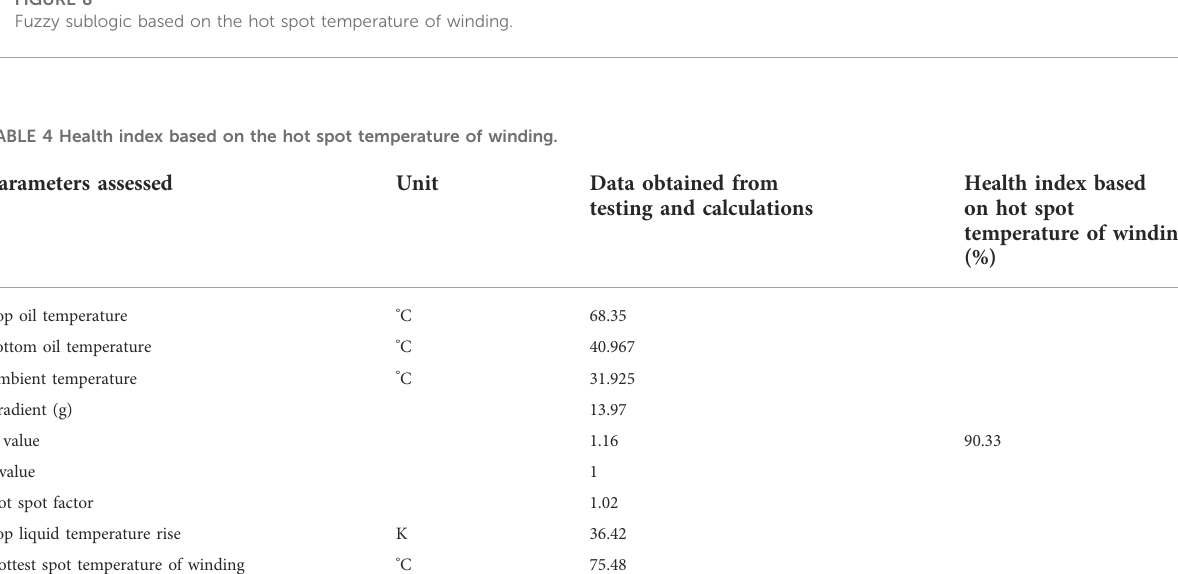
FIGURE 8 Fuzzy sublogic based on the hot spot temperature of winding.